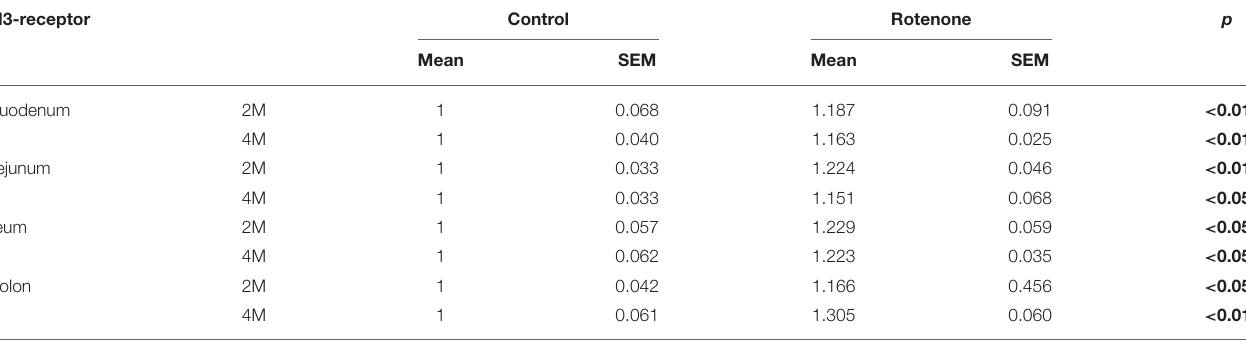
FIGURE 10 | (M3-muscarinic) (M3), and dopaminergic (D2) (Dopa D2R) receptors in duodenum (A) , jejunum (C) , ileum (E) , and colon (G) . The protein gene product 9.5 (PGP 9.5) was used as a panneuronal marker to determine the total neuronal population. Images were quantified using FIJI as described in the material and methods section. Protein expression for each marker was normalized to the amount of neuronal tissue in the sample by dividing it to the values obtained for PGP9.5 expression. Bar graphs in (B,D,F,H) show the quantification of the original blots ( n = 5). Data was analyzed using a Student’s t -test (Mann-Whitney Test). *, **, correspond to P < 0.05, and P < 0.01 respectively. n.s. non-significant. Error bars represent SEM in all